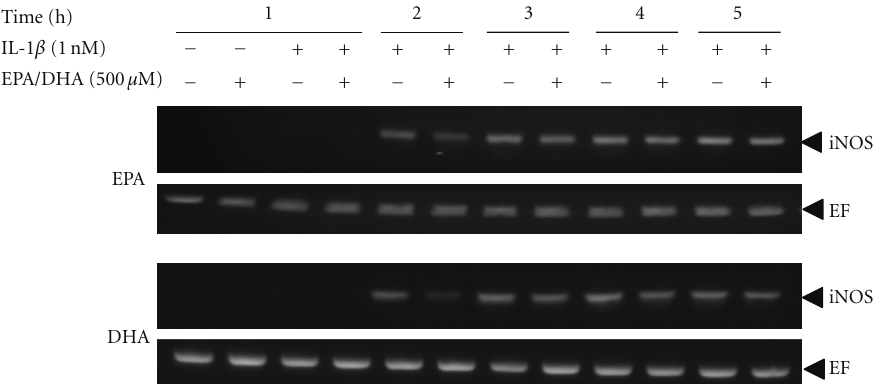
Figure 8: E ff ects of peroxidized EPA/DHA on the expression of iNOS mRNA. Cells were treated with IL-1 β (1nM) in the presence or absence of peroxidized EPA for 3 days and DHA for 1.5 days (each, 500 μ M) for the indicated times. Total RNA was analyzed by strand-specific RT- PCR to detect iNOS mRNA, using EF mRNA as an internal